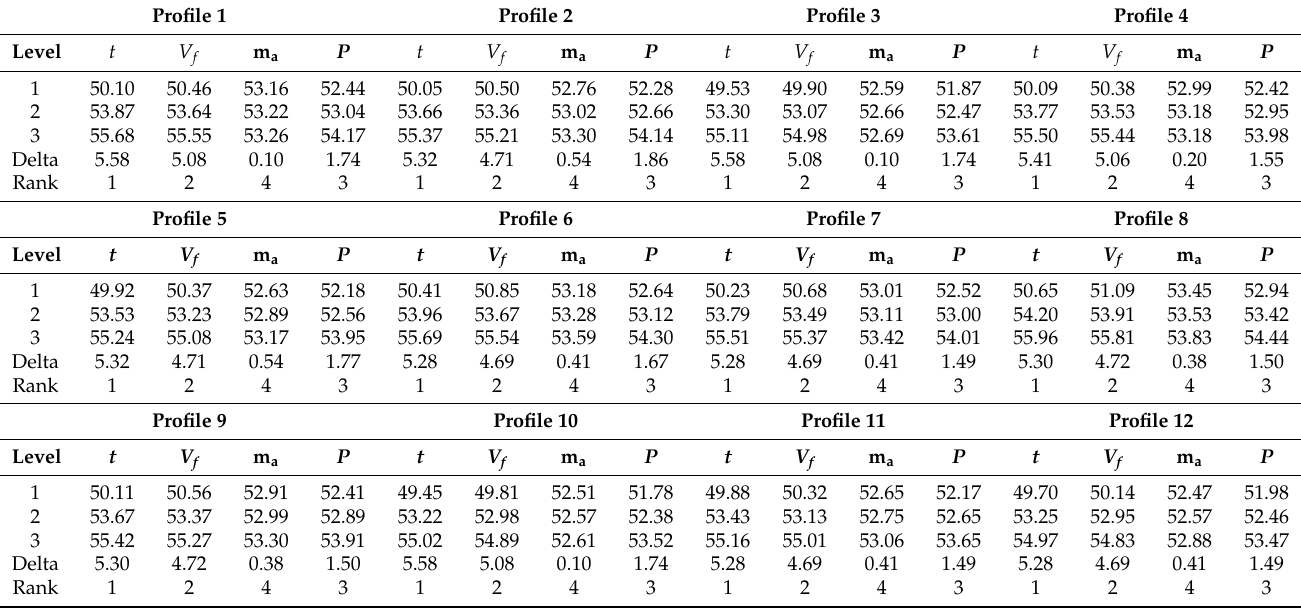
Table A4. Average response table for signal-to-noise ratios for material removal rate (larger is better). Profile